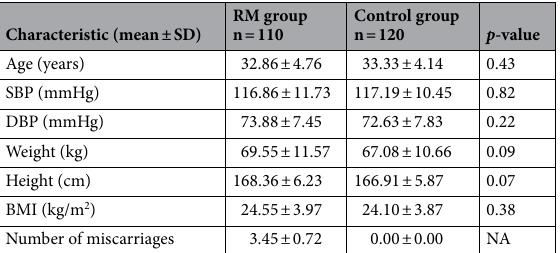
Table 1. Clinical data of recurrent miscarriages (RM) women and controls. SBD systolic blood pressure, DBP diastolic blood pressure, BMI body mass index. p -value—T